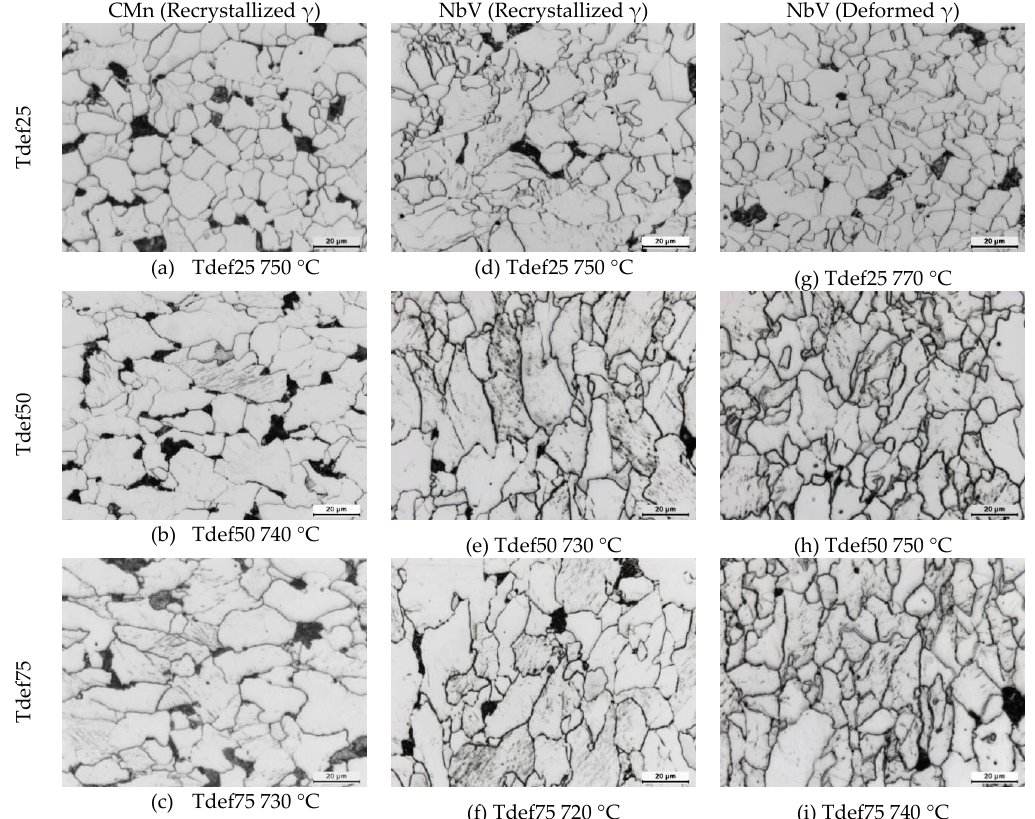
Figure 5. Optical micrographs obtained after air cooling at different deformation temperatures (( a , d , g ) Tdef25, ( b , e , h ) Tdef50, and ( c , f , i ) Tdef75) and different conditions: ( a , b , c ) CMn recrystallized austenite, ( d , e , f ) NbV recrystallized austenite, and ( g , h , i ) NbV deformed austenite.